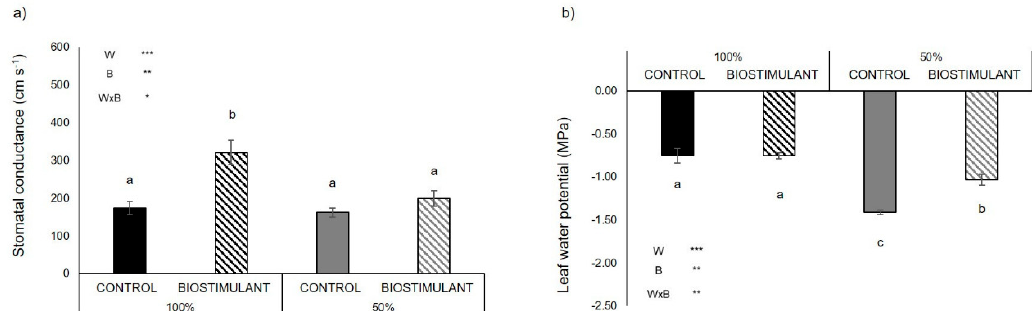
Figure 2. Stomatal conductance ( a ); and leaf water potential (MPa) ( b ); in the tomato genotype ‘E42’ grown in open field in Battipaglia under optimal (100% irrigation) and limited water availability (50% irrigation) and treated (biostimulant) or not (control) with the biostimulant. Values are mean ± SE. Asterisks indicate significant effect of limited water availability (W), biostimulant treatment (B) and their interaction (W × B) according to ANOVA (ns = not significant; * = p < 0.05; ** = p < 0.01; *** = p < 0.001). Different letters indicate significant differences based on Duncan’s test ( p ≤ 0.05).